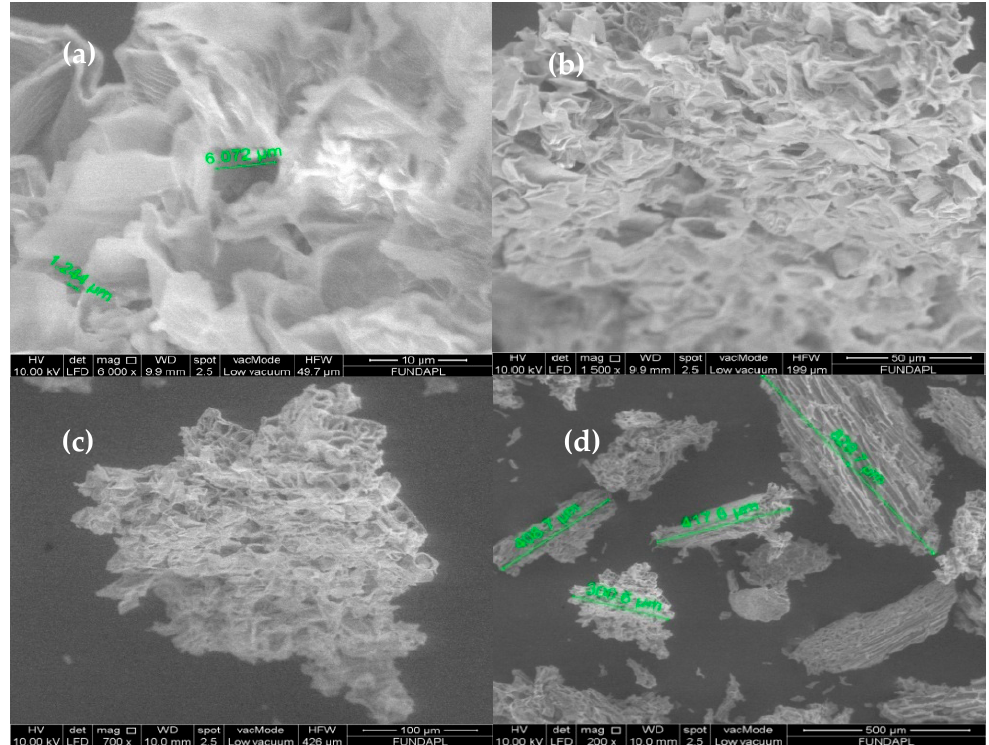
Figure 3. SEM of ALP after adsorption with different magnifications (( a ): 5 µm), (( b ): 20 µm), (( c ): 50 µm) and (( d ): 400 µm) .